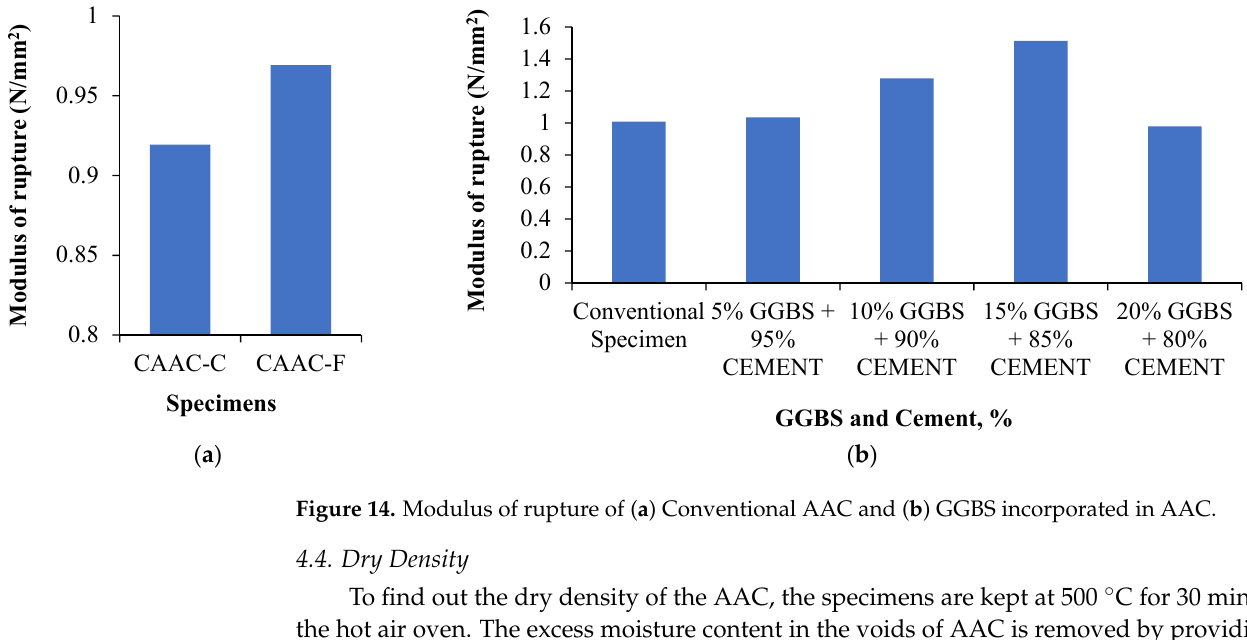
Figure 14. Modulus of rupture of ( a ) Conventional AAC and ( b ) GGBS incorporated in AAC.